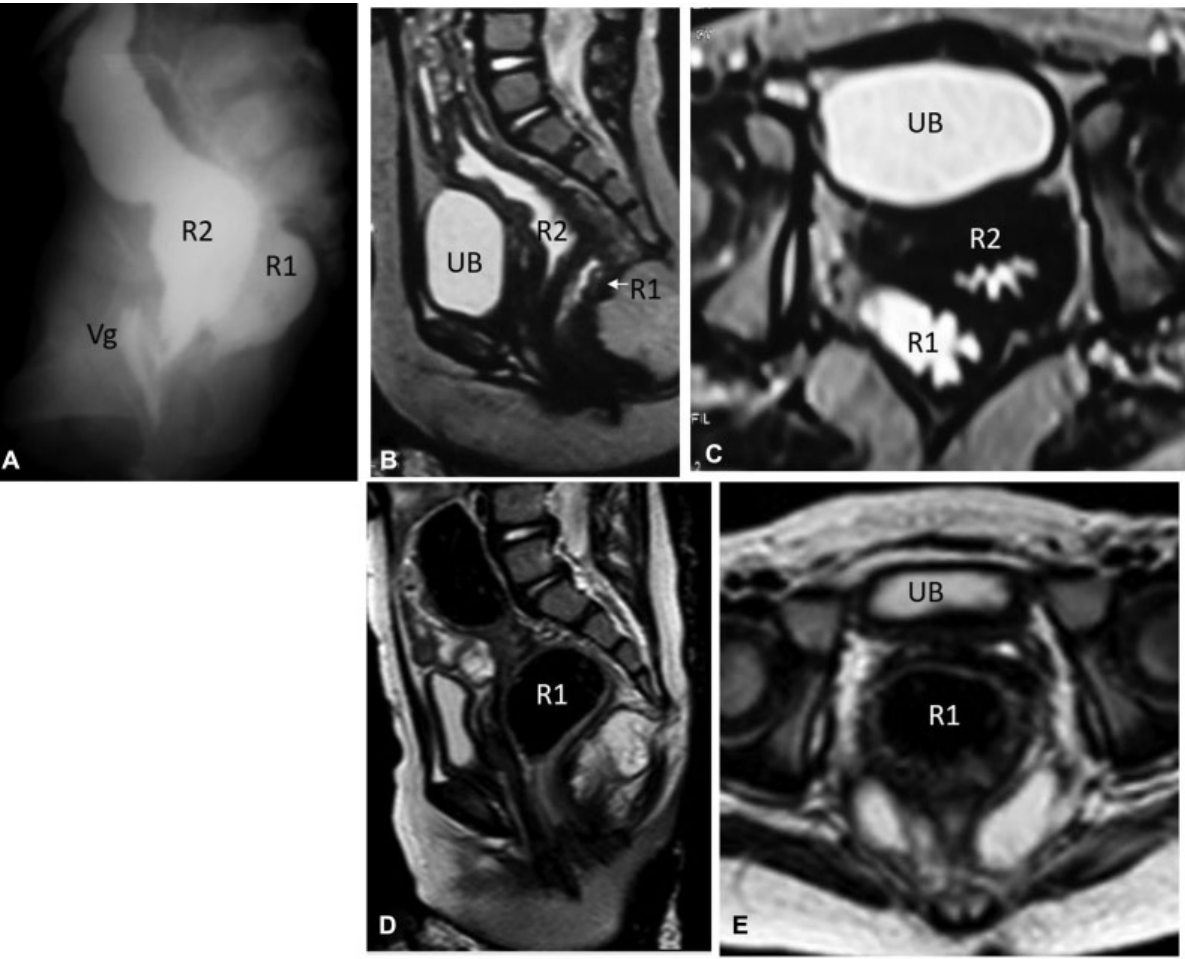
Fig. 1 A 2-year-old girl with complete colonic duplication on top of anorectal anomaly. The upper row demonstrates investigations performed before reconstruction:( A )contraststudiesthroughthetwodistal “ colostomy ” stomasdemonstratingoneposteriorcolonandrectum(R1)terminatingbytheneo- anus,andanotheranteriorcolonandrectum(R2)terminatingintothevagina(Vg);( B )and( C )midsagittalandaxialMRI(T2-WI),respectively,demonstrating theorientationofbothrecti(R1andR2)inrelationtoeachotherandtootherpelvicorgans(UB,urinarybladder).Notetheinjectionofgelthroughbothrecti tofacilitatetheiridenti fi cationinMRIbythehyperintensesignalofthegelinT2-WI.ThelowerrowdemonstratespelvicMRIanatomyfollowingreconstruction (afterexcisionofanteriorrectumR2,andclosureofcolostomy);( D )midsagittalplane;( E